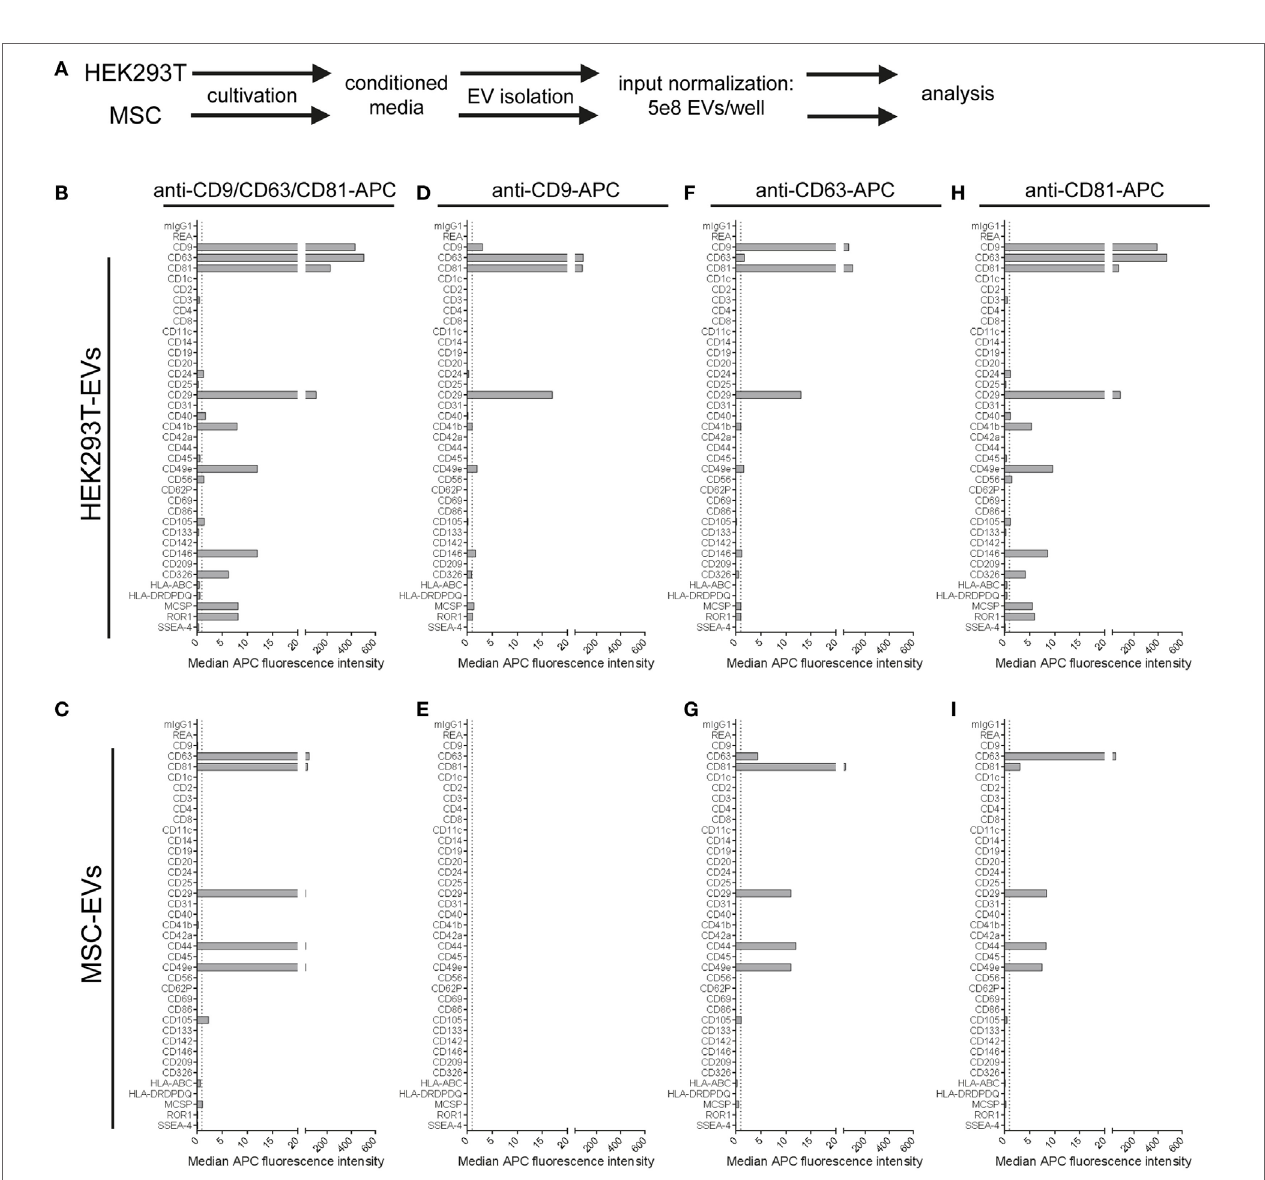
FigUre 5 | Assay compatibility with fluorescently labeled extracellular vesicles (EVs). (a) Schematic outline of the lentiviral vector used. Abbreviations: CMV, CMV promoter; SD, splice donor; LTR, long terminal repeat; SA, splice acceptor; RRE, Rev responsive element; cPPT, central polypurine binding tract; SFFV U3, U3 promoter of the spleen focus forming virus; IRES, internal ribosomal entry site; puroR, puromycin resistance cDNA; WPRO, woodchuck hepatitis virus post- transcriptional regulatory element optimized, modified after Wiek et al. (62). (B) Capture bead distribution after overnight incubation with unmodified or CD63- mNeonGreen EVs. (c) Capture bead signals in the APC channel after incubation with EVs labeled with far-red fluorescent proteins (mCardinal and E2-Crimson). (D) Signals detected in APC and VioBlue channels for unstained and stained (pan tetraspanin) CD63-Cerulean EVs. See Figure S6 and Table S2 in Supplementary Material for further details.